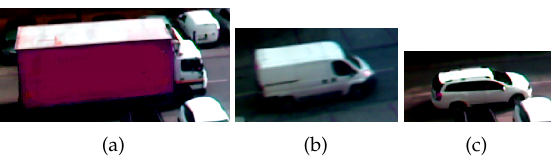
Figure 7. Vehicles for which VMPs were registered and analyzed: ( a ) a truck, ( b ) a delivery car, and ( c ) a passenger car.